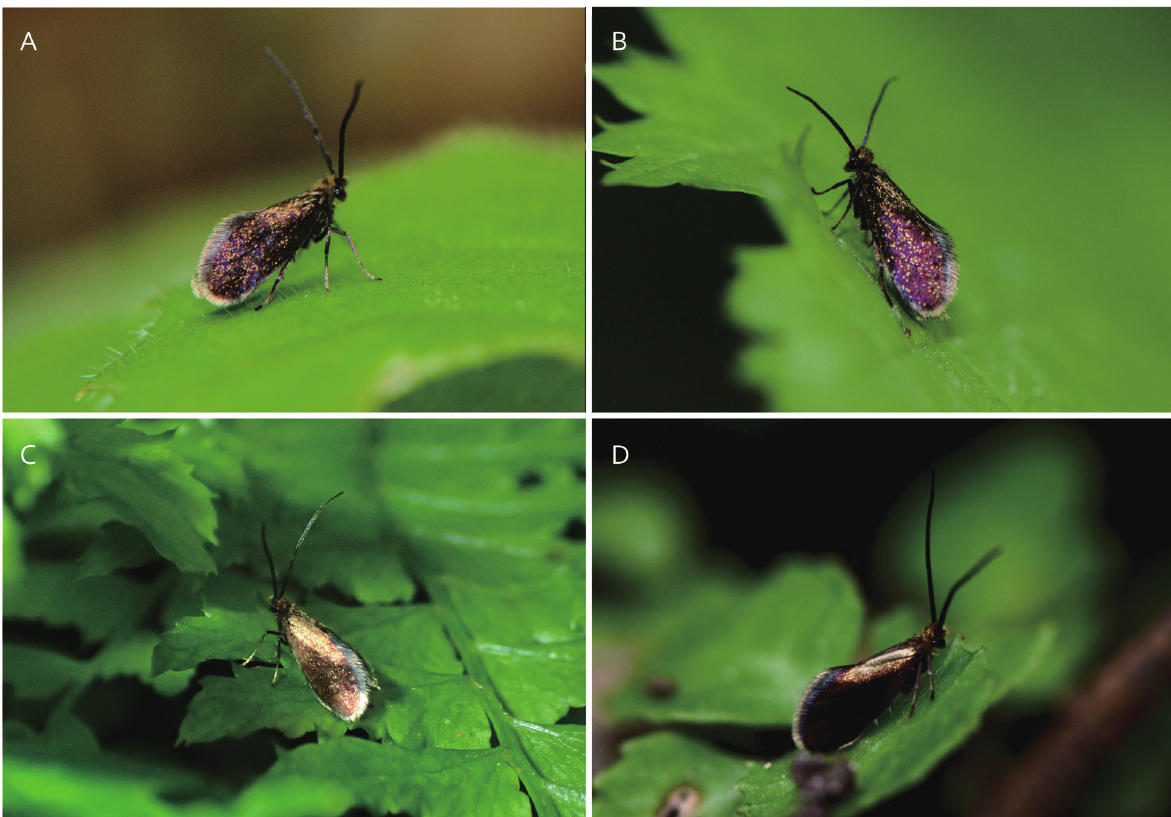
Figure 18. Ecology. A: Issikiomartyria catapasta sp. n. at Tachimata-keikoku, Akita Pref; B: I. trochos sp. n. at Jintsu-kyo, Yamagata Pref; C: I. trochos sp. n. at Mahirudake-rindo, Iwate Pref; D: Melinopteryx bilobata sp. n. at Ushikubi-touge, Shizuoka